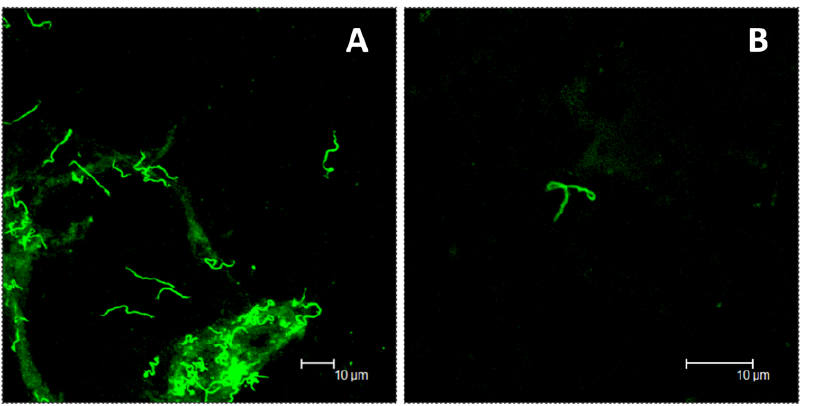
Figure 5. Spirochetes recovered by xenodiagnosis from animals treated in the disseminated phase of infection. Images from direct fluorescent staining of B. burgdorferi spirochetes found in xenodiagnostic tick midgut culture (A) or tick midgut preparation (B) from treated animals GA59 and GB56, respectively.